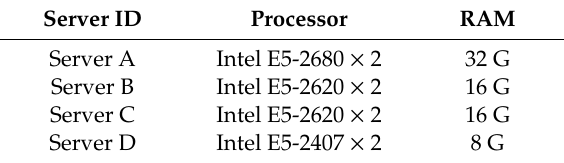
Table 1. The basic specifications of the computing clusters in terms of the processor and